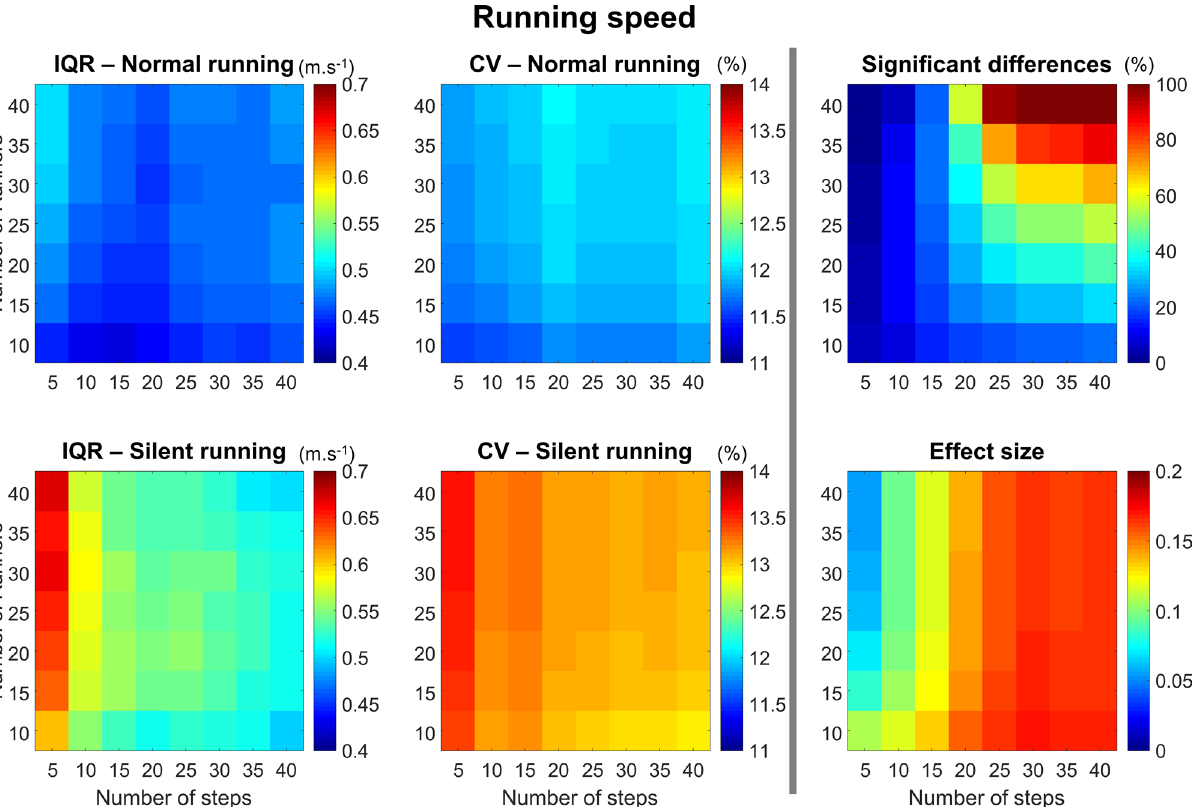
Figure 10. Colormaps demonstrating running speed interquartile range (IQR, left column ) and coefficient of variation (CV, central column ) from the combination of 10–40 runners versus 5–40 running steps. Data is shown from normal running ( top panels ) and silent running ( bottom panels ). Each value is an average from 100,000 paired permutations for each combination. The number of significant differences ( p < 0.05, expressed as a percentage of 100,000 comparisons, top right panel ) and their respective effect size ( bottom right panel ) illustrate the changes in statistical outcomes depending on the combination of number or runners versus number of